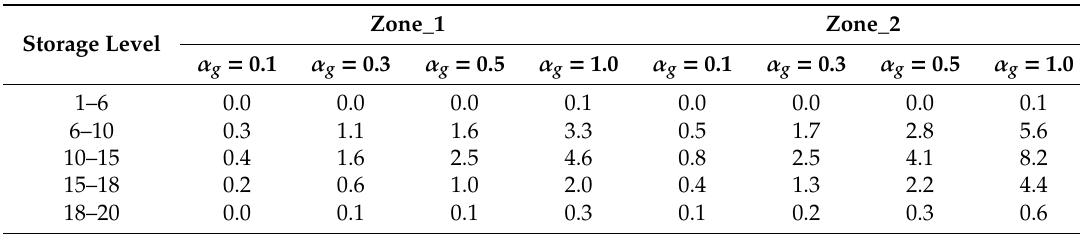
Table 4. Interstory drift ratio (in percentage) evaluated via MRSA.